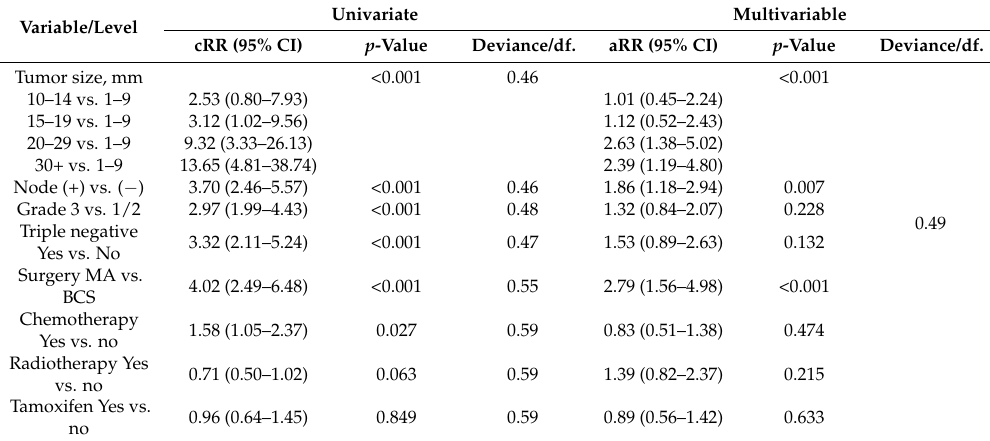
Table 2. The univariate and multivariable analysis of Poisson regression model for predicting breast cancer death by conventional tumor attributes and other predictors.